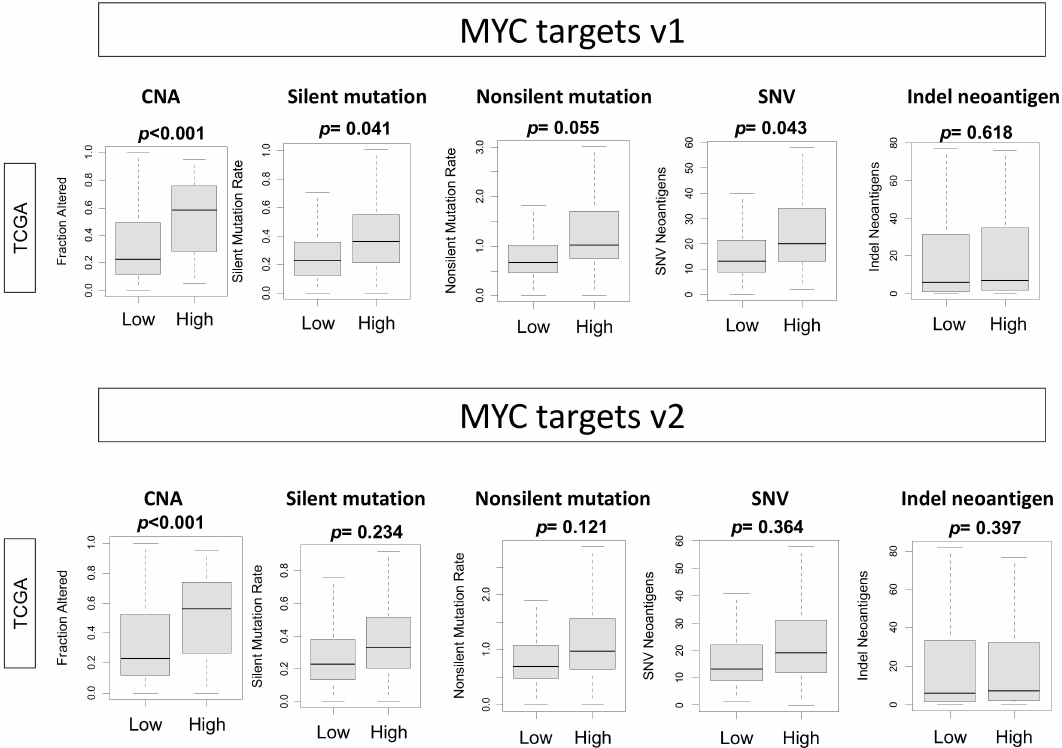
Figure 4. Association of the MYC targets v1 and v2 scores with mutation-related scores in ER-positive / HER2-negative breast cancer in the TCGA cohort. Boxplots depicting high and low MYC v1 and v2 scores associated with mutations assessed as copy number alteration (CNA), silent and nonsilent mutations, single-nucleotide variation (SNV), and insertion and deletion (Indel) mutations. One-way ANOVA was used for